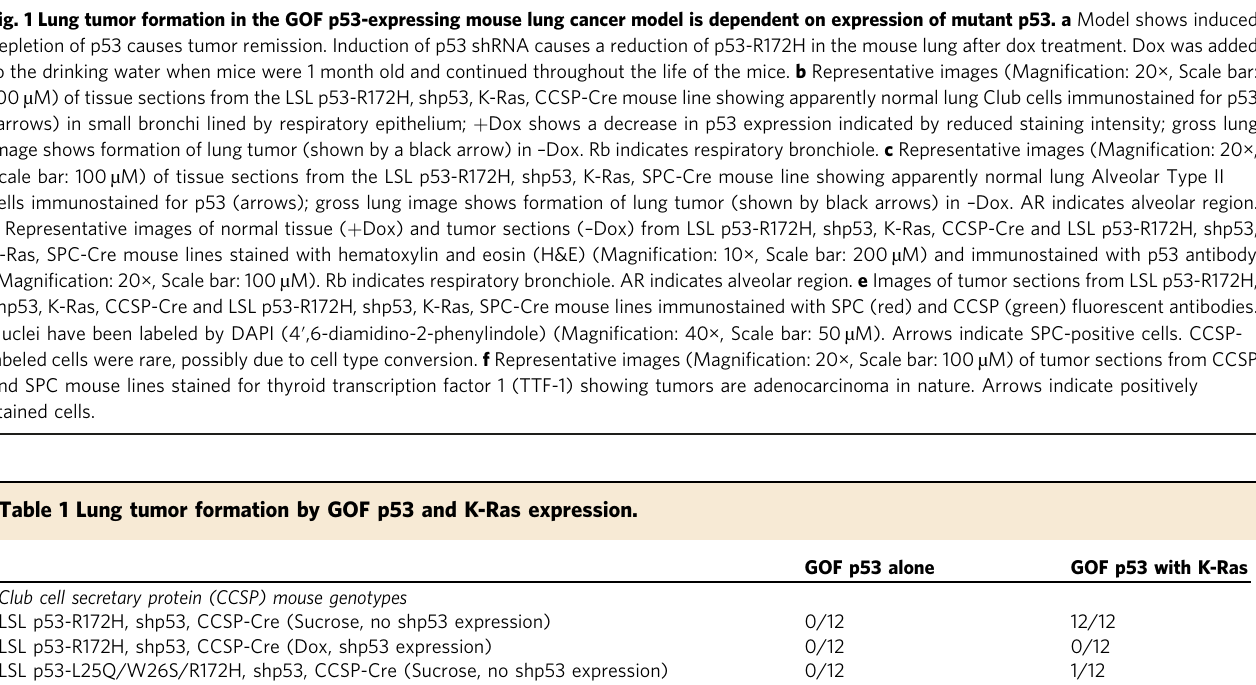
GOF p53 alone GOF p53 with